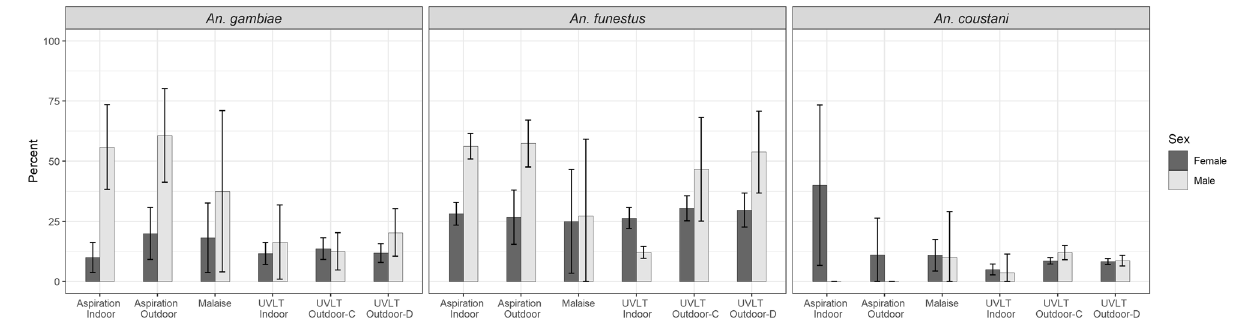
Figure 1. Sugar feeding rates of An. gambiae , An. funestus and An. coustani by collection method, location, species, and sex. Error bars represent the 95% confidence